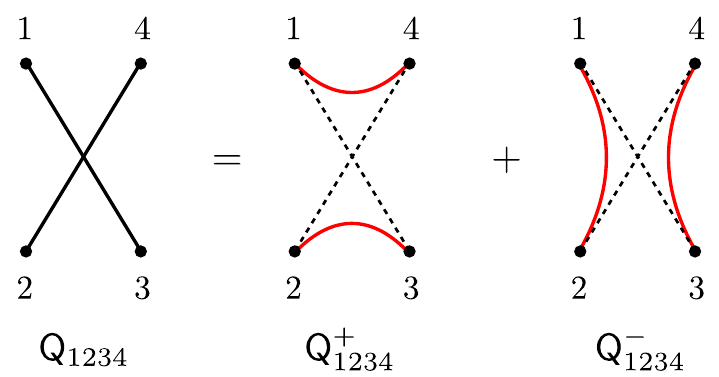
Figure 42 . The decomposition of the scalar quartic diagram. One can decompose the scalar quartic diagram into two di(cid:11)erent Wick contraction